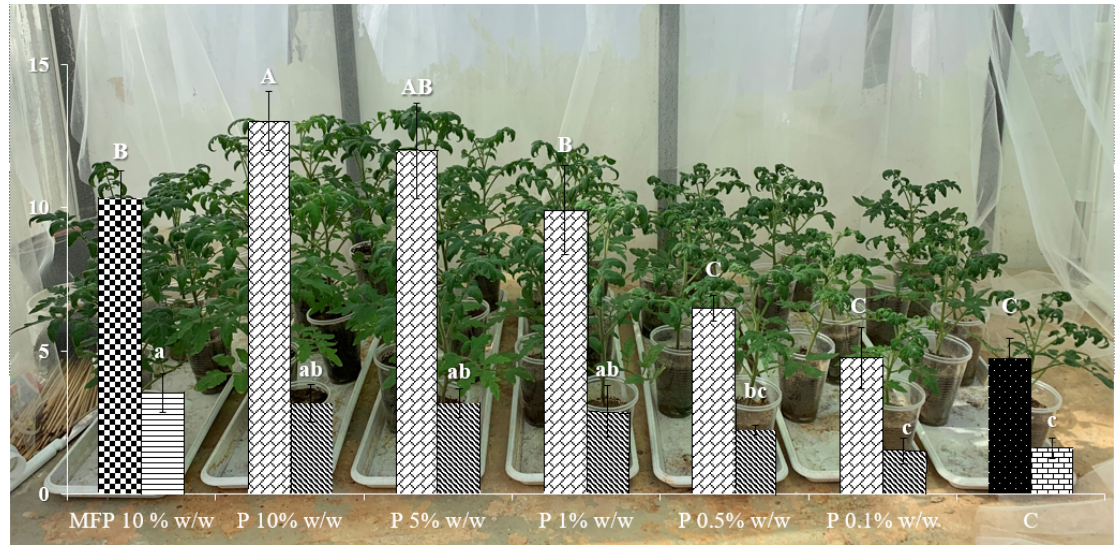
Figure 4. Weight increase of aerial parts and tomato roots after treatment with lemon thyme powder (P) at 0.1 to 10% against Melia azedarach powder 10% (MFP) and water control (C). Data are presented as means of five replicates with standard deviations. Means followed by the same letter are not significantly different according to Tukey’s test ( p ≤ 0.05). Upper case letters correspond to statistical differences on fresh aerial parts weight. Lower case letters correspond to statistical differences on fresh roots weight.